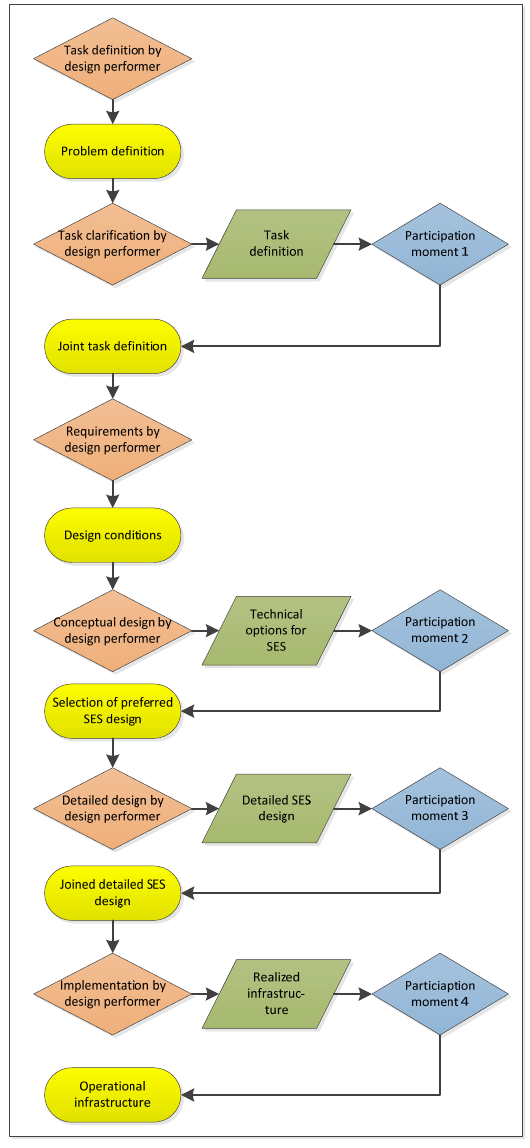
Figure A1. Flowchart for the decision ‐ making model.